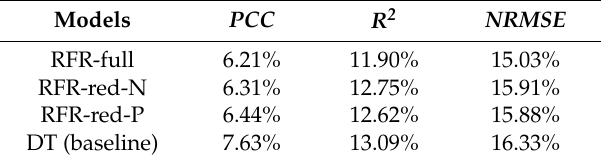
Table 4. Coefficient of variations of model accuracies of the RFR and baseline